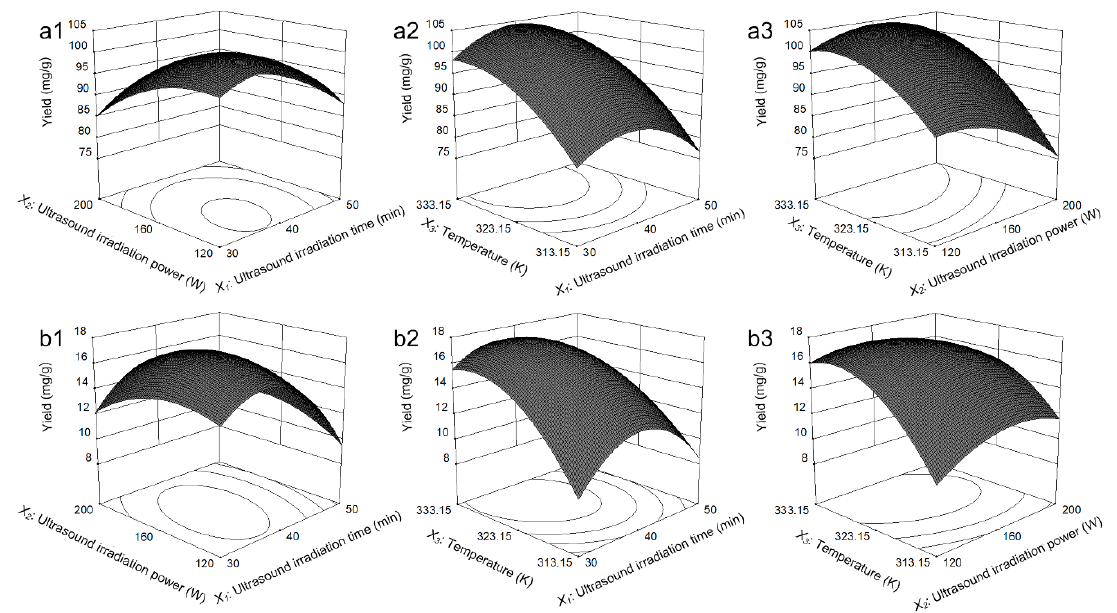
Figure 7. Response surface and contour plots. ( a1 ) Effect of extraction time and ultrasound irradiation power on the extraction total yields of the 3 flavonoids from the leaves of A. nephrolepis , ( a2 ) effect of extraction time and temperature on the extraction total yields of the flavonoids from the leaves of A. nephrolepis , ( a3 ) Effect of ultrasound irradiation power and temperature on the extraction total yields of the 3 flavonoids from the leaves of A. nephrolepis , ( b1 ) Effect of extraction time and ultrasound irradiation power on the extraction total yields of the 3 flavonoids from the bark of A. nephrolepis , ( b2 ) effect of extraction time and temperature on the extraction total yields of the flavonoids from the bark of A. nephrolepis , ( b3 ) Effect of ultrasound irradiation power and temperature on the extraction total yields of the 3 flavonoids from the bark of A. nephrolepis .